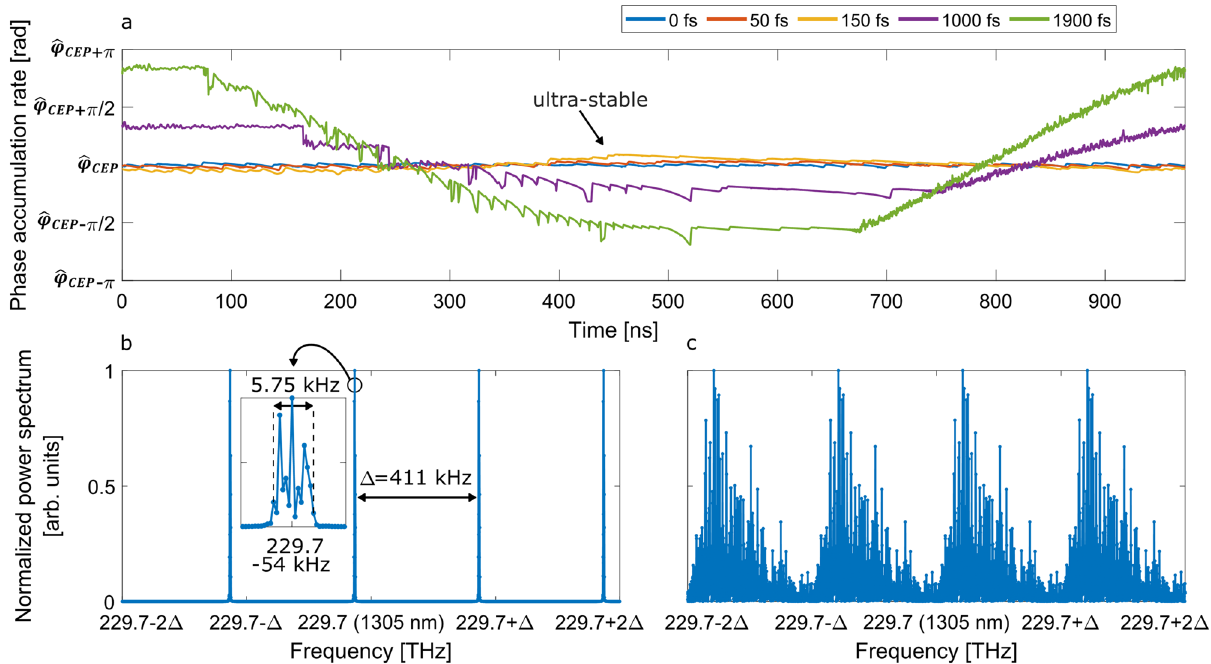
Fig. 5 Numerical simulation of the Fourier domain mode-locked (FDML) output. a The all-mode phase evolution plot presents the relative